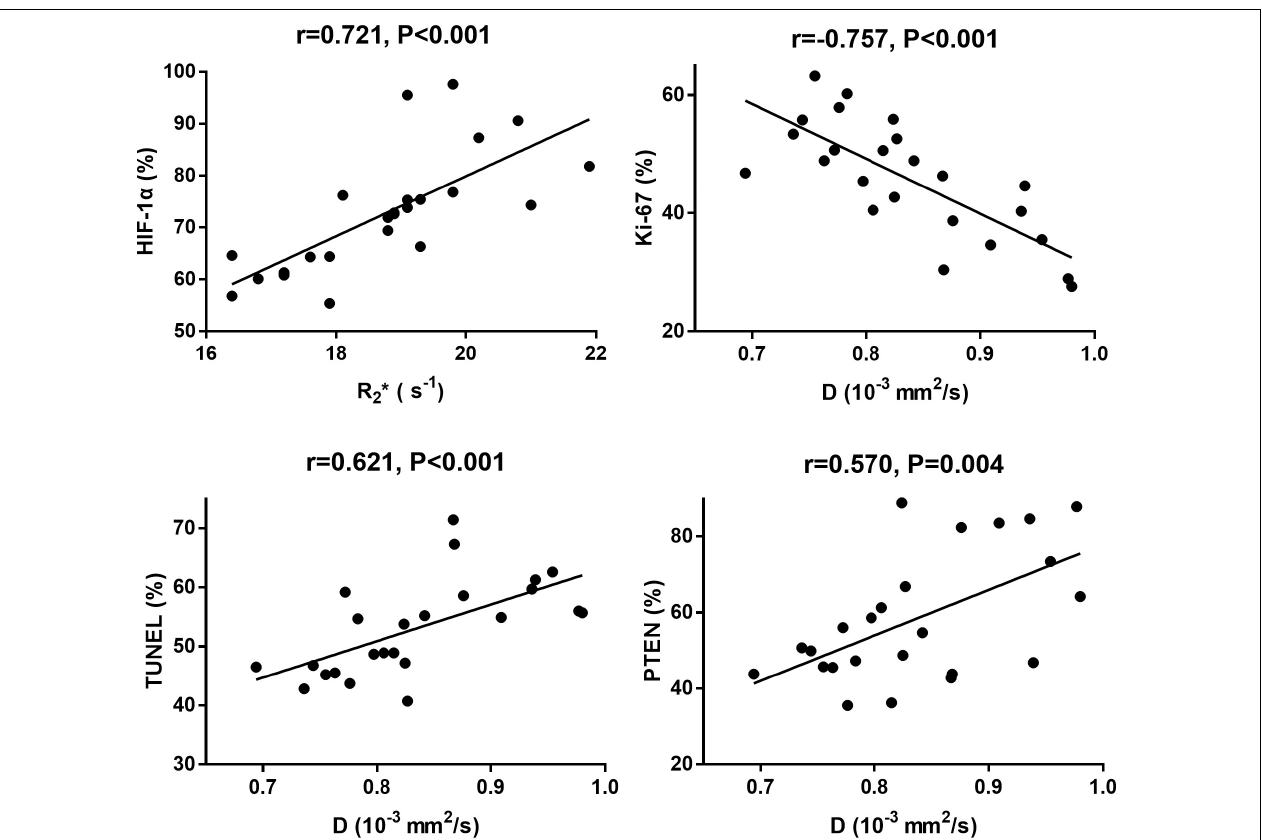
FIGURE 10 | The scatter chars plotted the highest correlations between MRI parameters and each pathological